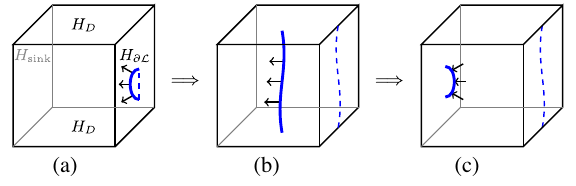
¯ Z FIG. 12. Implementing a logical operator through a sequence of local moves. (a) An error chain Z ð c Þ supported on dual qubits (the union of the solid blue and dashed blue lines) is created near the toric code boundary. This error chain creates string excitations in the bulk (solid blue), and anyonic excitations where it meets the toric code boundary. (b) The loop is grown until it consists of ¯ Z a logical operator (dashed blue line) along with a large bulk excitation (solid blue) anchored between the two dual boundaries. (c) The bulk excitation is moved to the sink boundary, where it ¯ Z can be absorbed. The whole process results in a logical . Logical ¯ X operators can be implemented in a similar way, where an error loop on the primal lattice is grown and propagated, and an additional chain of Pauli- X errors is also propagated along the toric code excitation caused by Z ð l 0 Þ to the sink boundary, following Fig. 12 (which can be achieved with local symmetric moves as the two loops are homologous). This operator and the corresponding excitations can then be absorbed by the sink boundary as it is dual condensing.